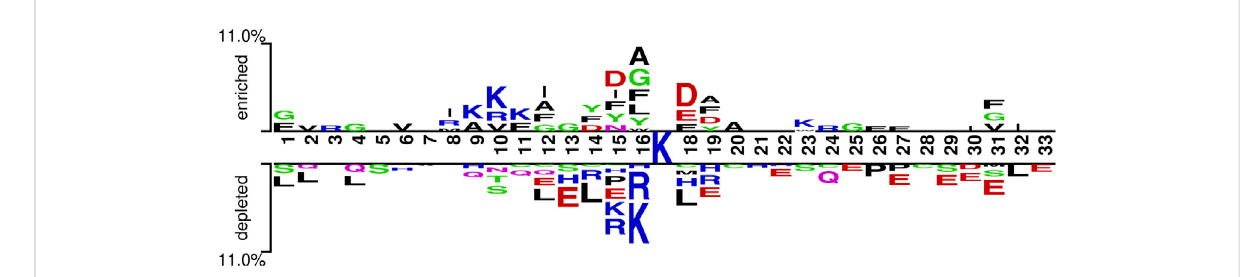
FIGURE 9 The statistical two-sample logo analysis with t -test on the samples ( p -value < 0.05).